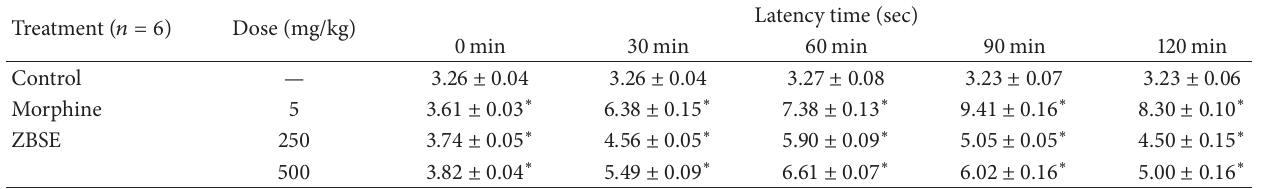
Table 5: Effect of Z. budrunga seed extract in hot-plate test on mice.